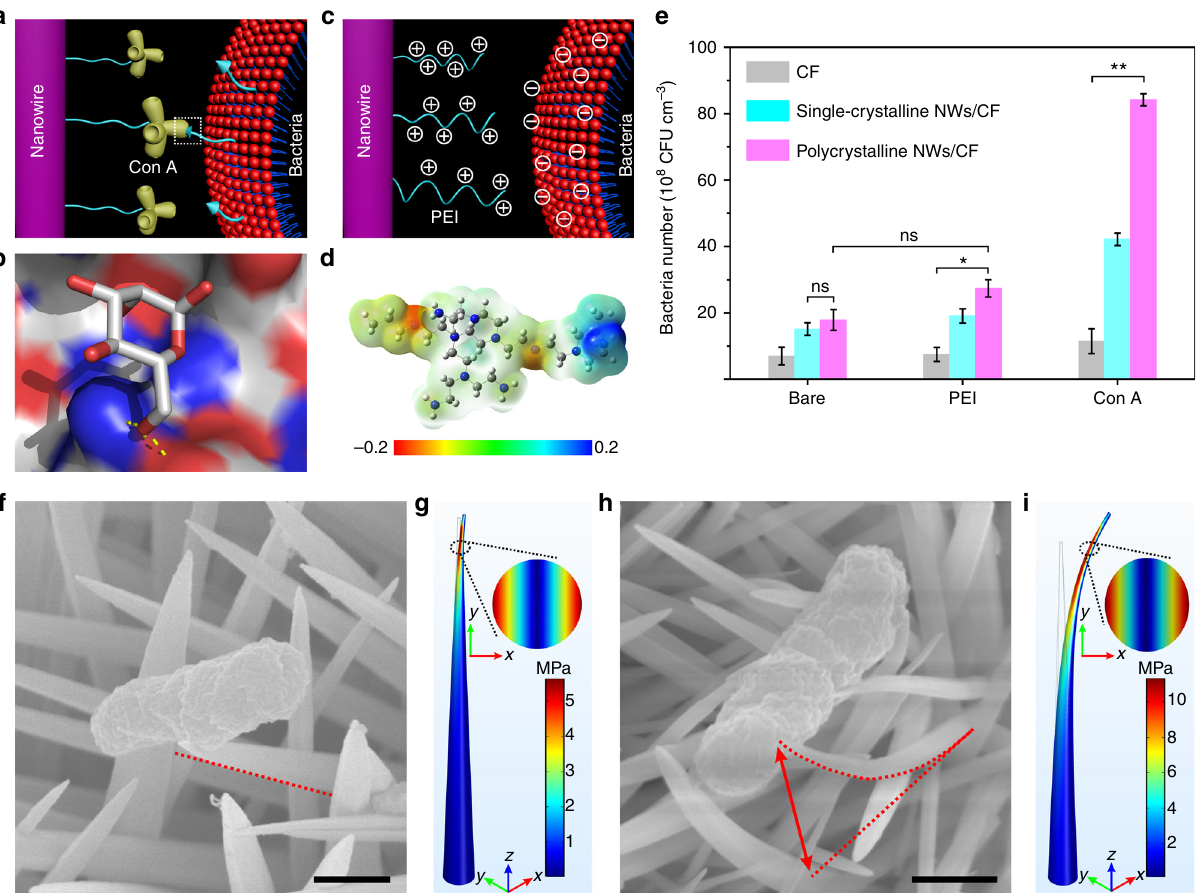
Fig. 4 Characterization of 3D nanoclaws formation. a Con A on NW surfaces bound to mannose on the bacterial membrane. b The graph shows the hydrogen bonds (yellow sticks) in the crystal structure of the binding site of mannose to Con A (PDB code 1i3h) using the PYMOL software. c Illustration of electrostatic interactions between the cationic polymer of PEI modi fi ed on NW surfaces and bacterial membranes. d An electrostatic potential map for a representative conformation of PEI. e Comparing the bacterial capturing capacity of different molecules modi fi ed on NW surfaces at a fl ow velocity of 10 cm s − 1 . Error bars: standard error ( n = 3). Student ’ s t -test, ** P < 0.01; ns, not signi fi cant. f – i SEM measurements and FEM simulations for the de fl ection distance of NWs after bacterial capture, f single-crystalline and h polycrystalline NWs of SEM images. The von Mises stresses of g a single-crystalline and i a polycrystalline NW concentrated at the NW tips under constant displacements of 100 nm and 1 μ m, respectively. A 2D diagram corresponding to the von Mises stress at a height of 4.5 μ m (inset). Scale bars in f and h are 500